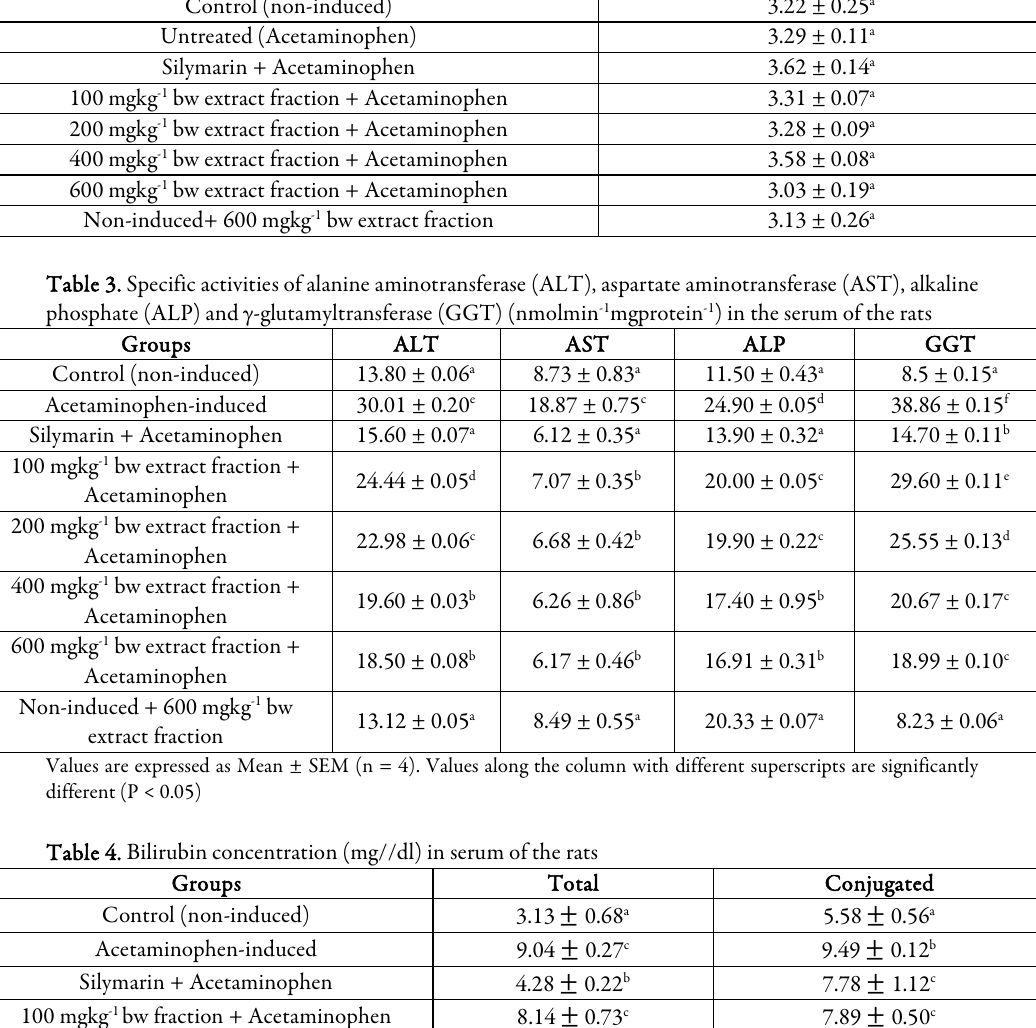
Table 2. Liver to body weight ratio of acetaminophen-induced rats pre-administered with ethyl acetate- ethanolic extract fraction of Carica papaya leaves